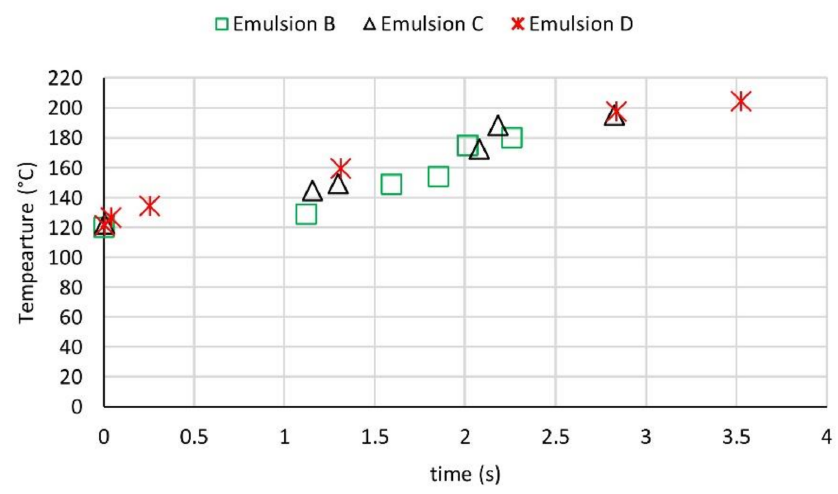
Figure 7. Temperature profiles of case B, C and